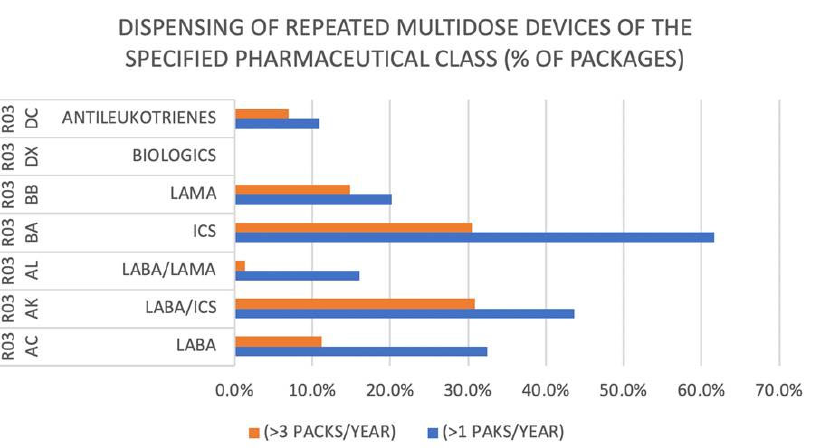
Figure 2. Evaluation of adherence to several respiratory medications (Anatomical Therapeutic Chemical classification code R03). Table 5. The percentages represent the ratio of number of patients taking at least 3 packages of two drugs to the total number of